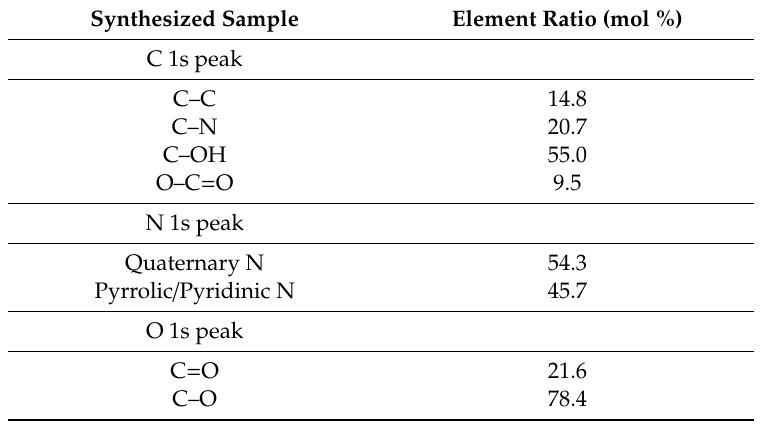
Table 1. XPS analysis showing di ff erent percentages of bonding groups in PEG 6000 / CD